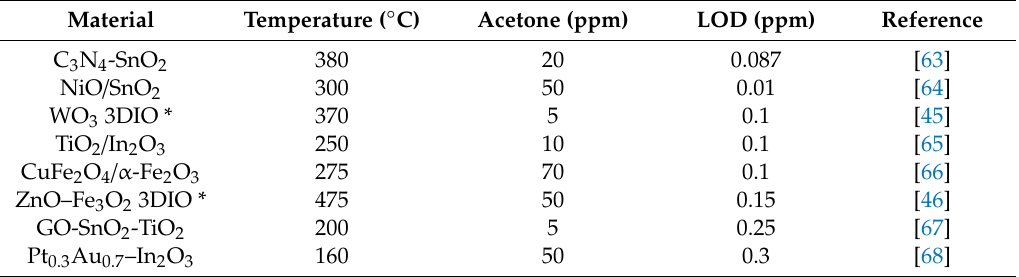
Table 3. Summary of the literature review of selected PhC and metal-oxide based sensors for acetone detection. The columns, from left to right, indicate the sensor’s material, the optimal operation temperature, the quantity of acetone (concentration) used for the test, the limit of detection (LOD), and the bibliographic reference. Adapted from